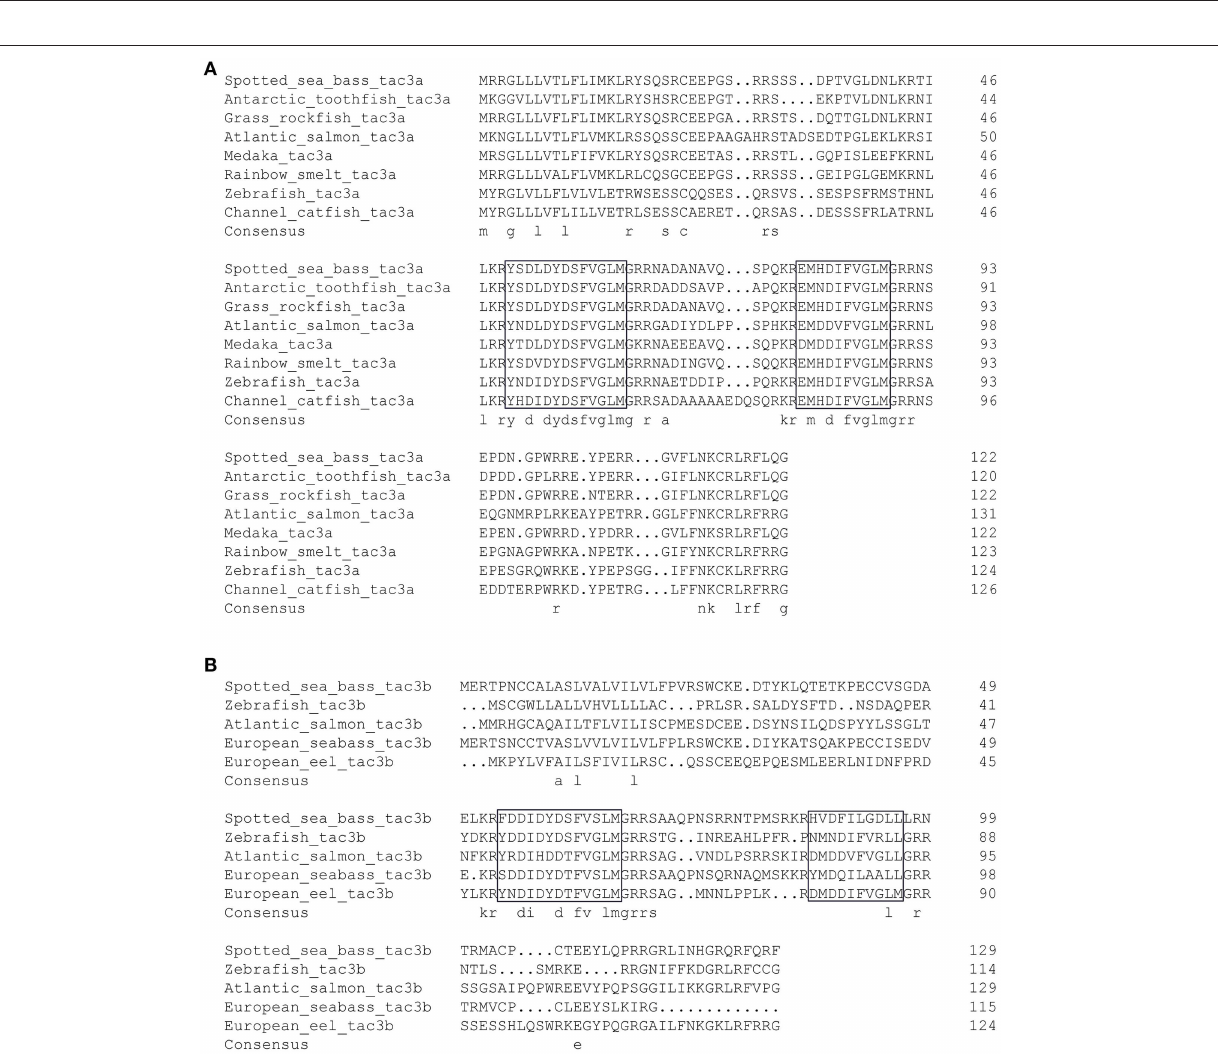
Frontiers in Endocrinology |